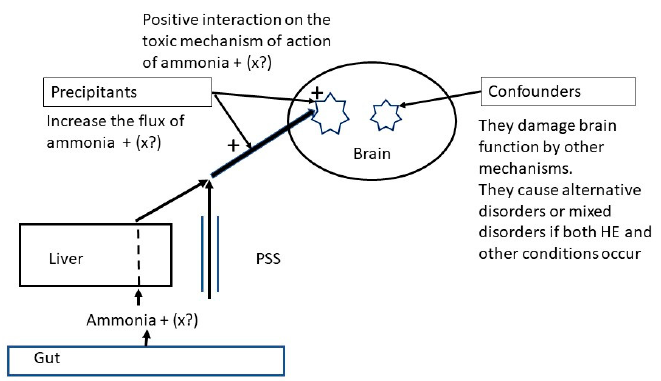
Figure 1. Schema showing the different concepts of precipitants and